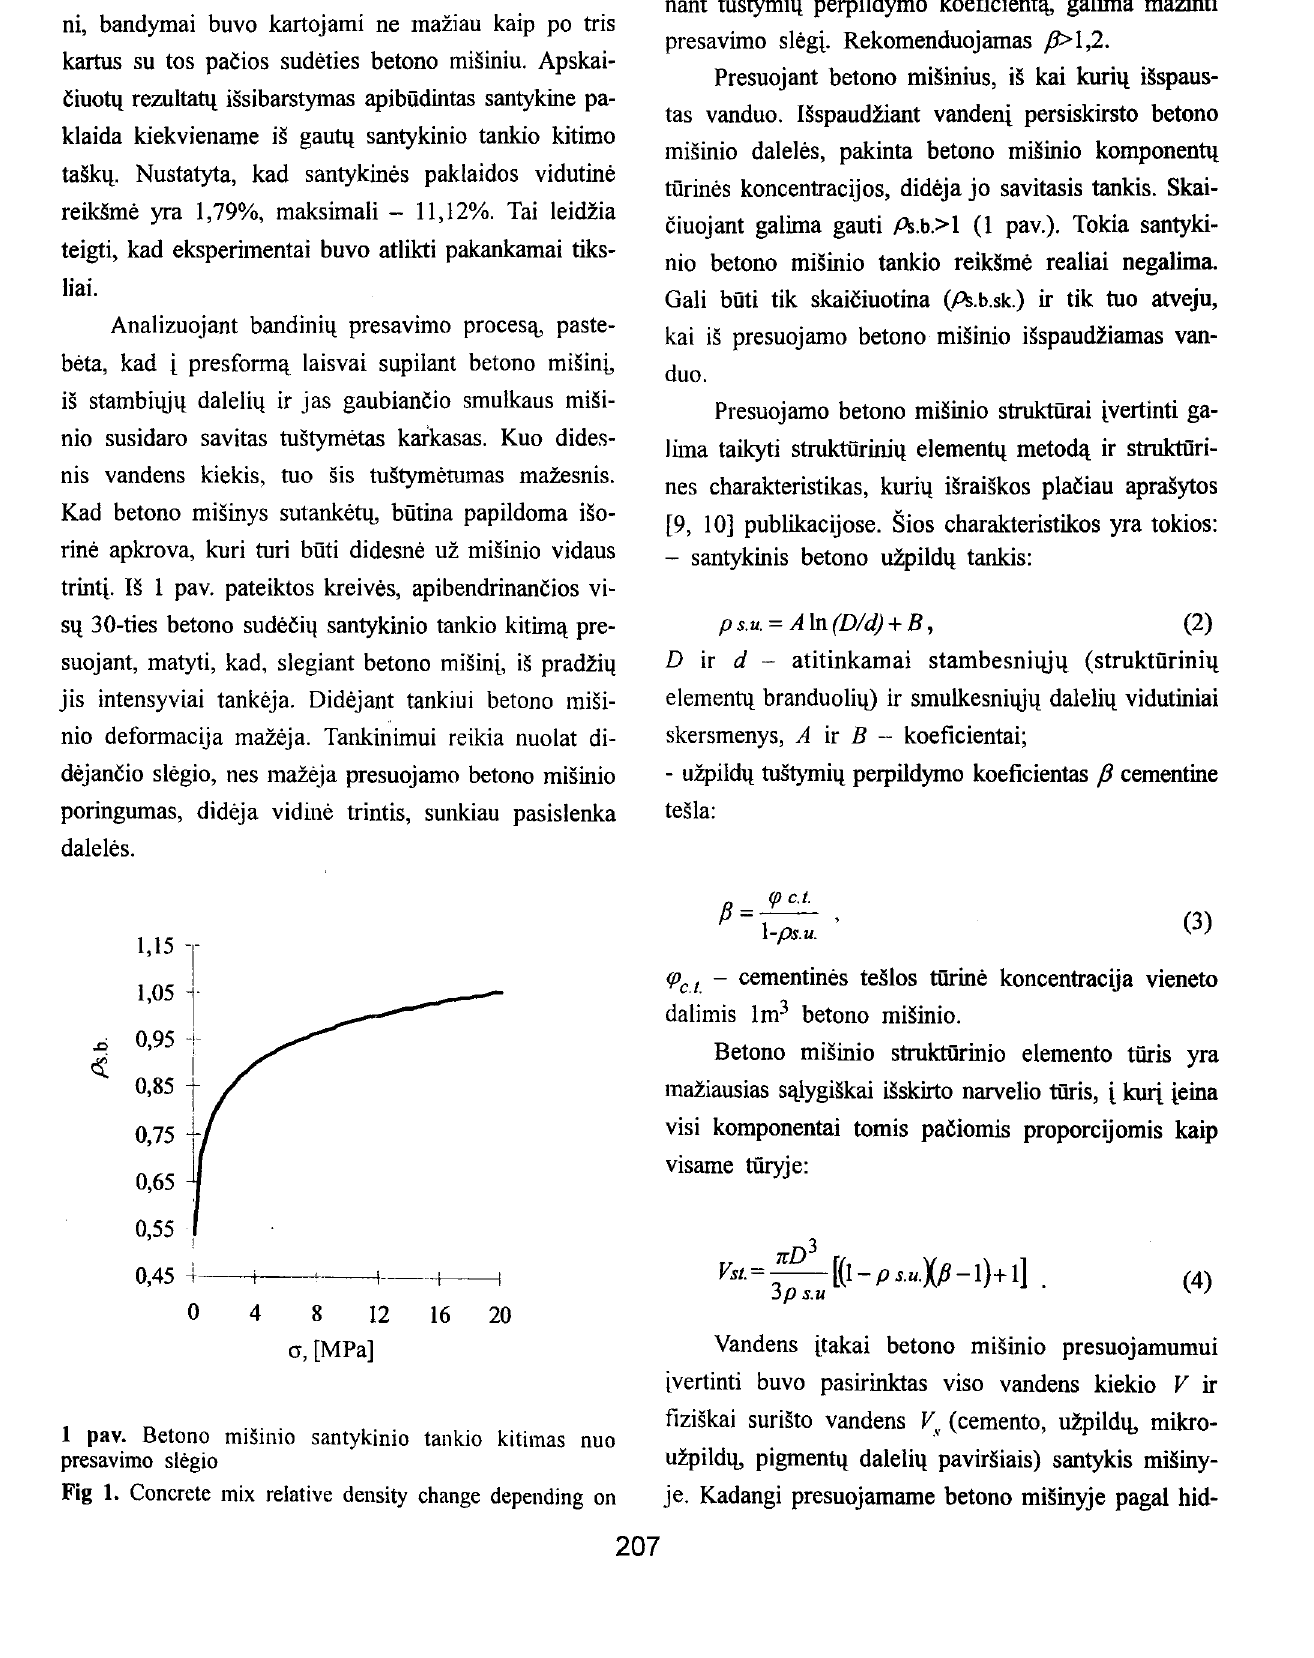
Fig 1. Concrete mix relative density change depending